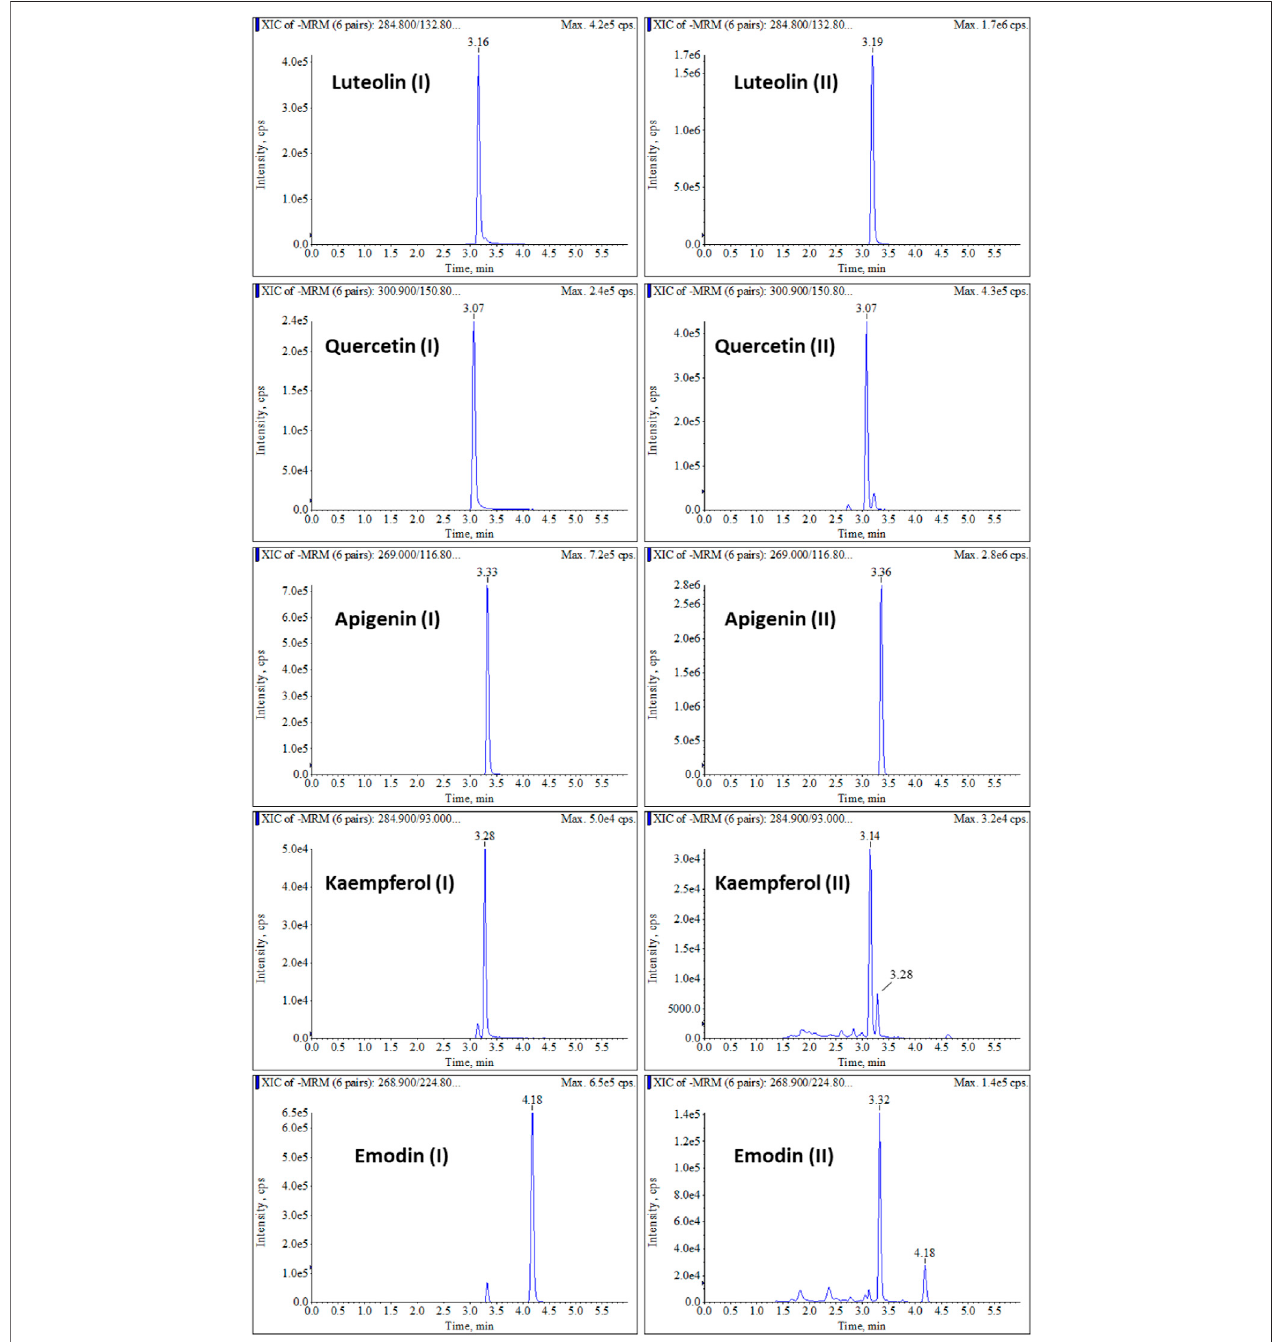
FIGURE2| ChromatogramsofHPLC-MS/MSofFY.[(I)Standardsolution;(II)SamplesolutionofFY;RetentiontimeofKaempferolandEmodinwere3.28and4.18 min, respectively].